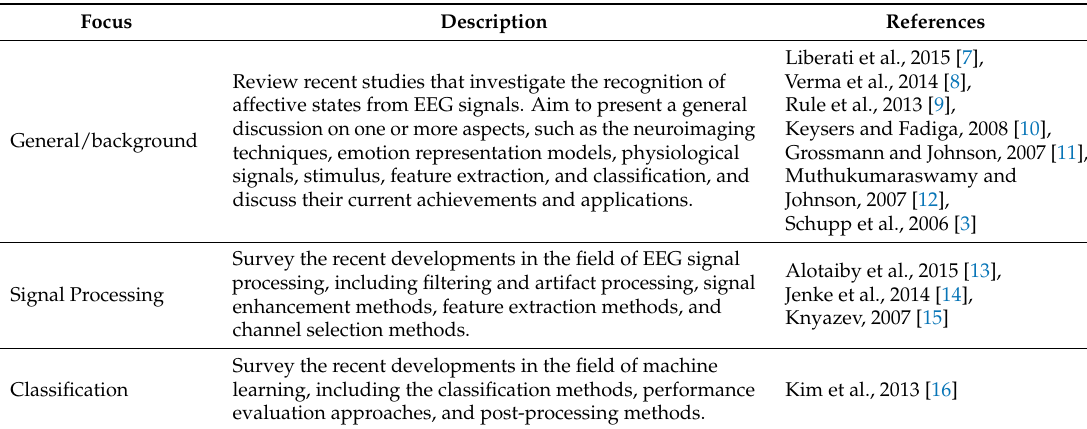
Table 1. Review article